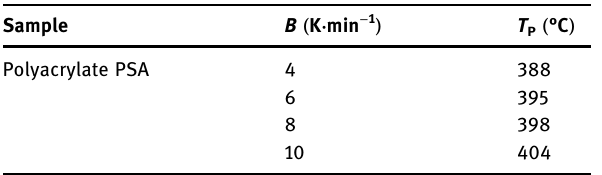
Table 2: Values of E and A by using Flynn – Wall – Ozawa